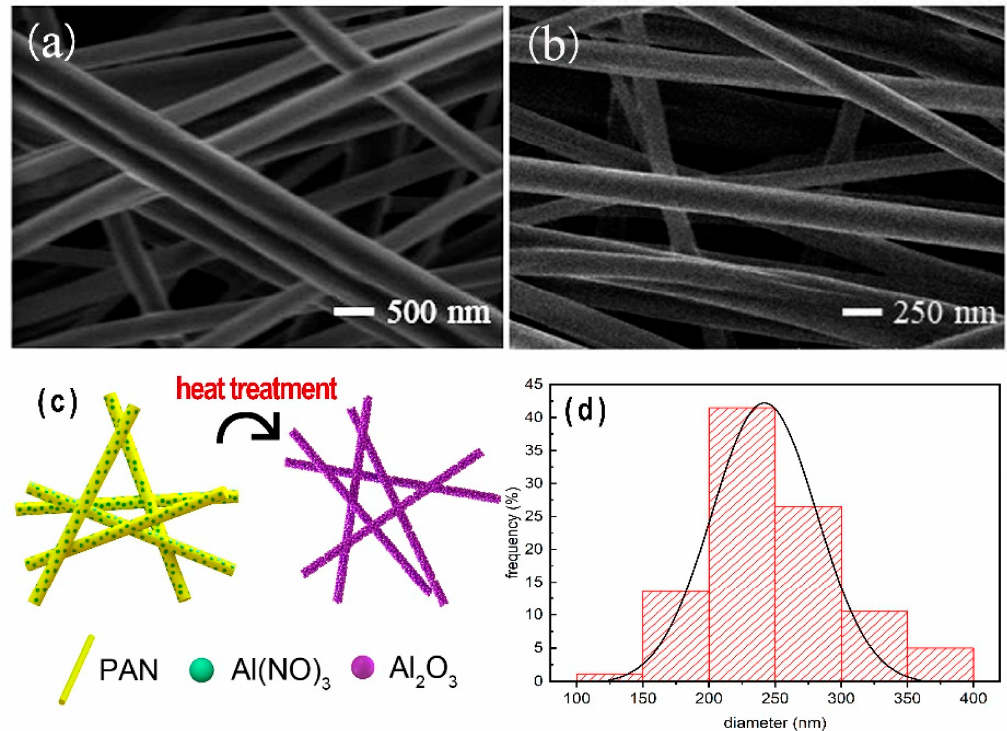
Figure 5. SEM images of Al 2 O 3 coatings made by electrospinning technique before ( a ) and after heat treatment ( b ). Sketch illustrating the formation mechanism of the Al 2 O 3 nanofibre coatings ( c ). The diameter distribution of Al 2 O 3 nanofibres after thermal treatment ( d ). Reprinted with permission of [51].